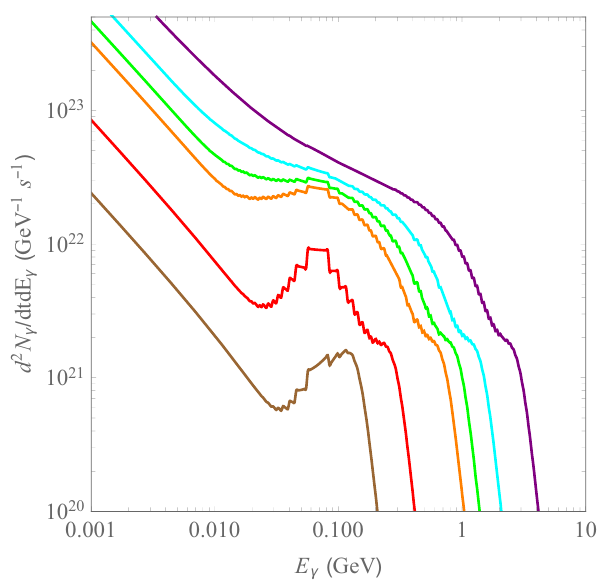
Figure 3 . Photon spectrum for ˜ a = 0 PBHs with masses 2 . 5 , 5 , 7 . 5 , 10 , 25 and 50 × 10 10 kg (purple, cyan, green, orange, red and brown, respectively), obtained using